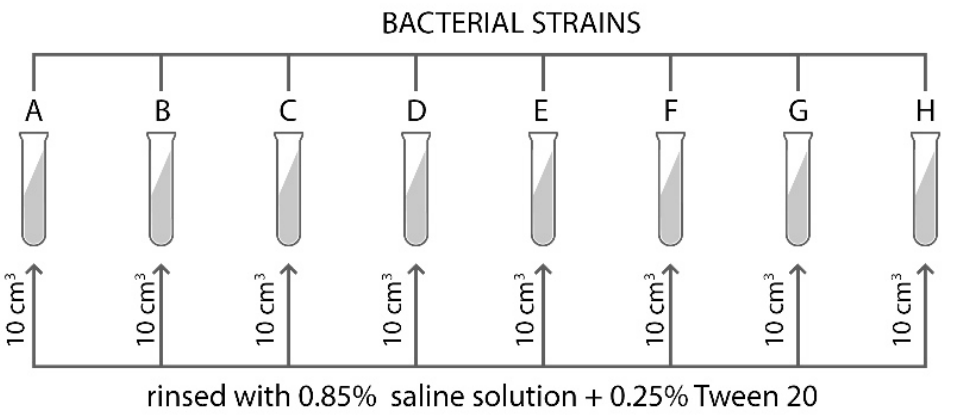
Figure 1. Diagram of preparation of bacterial inoculum (source: own study).